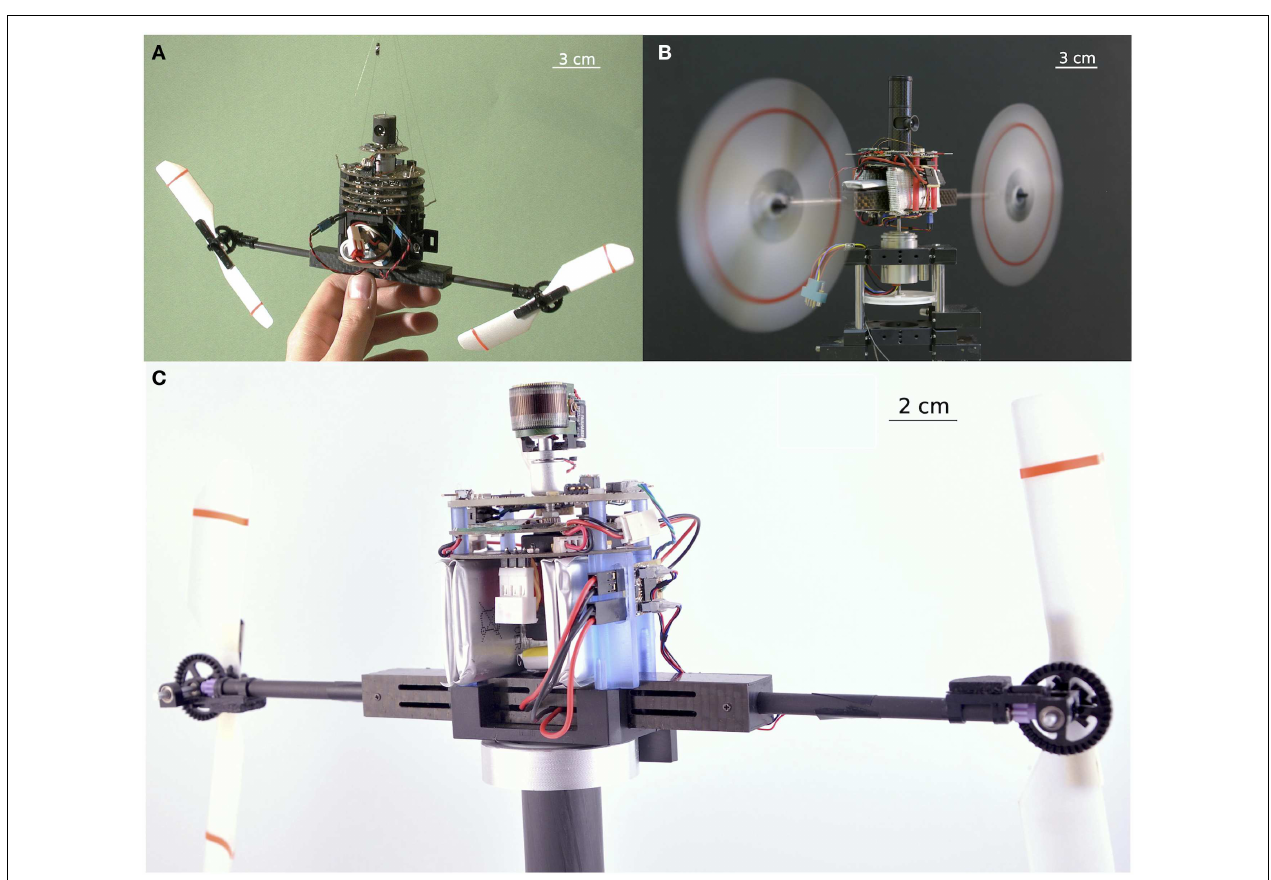
(Viollet and Franceschini, 1999a,b, 2001). (B) TheVODKA robot equipped with its scanning eye, on which periodic micro-scanning movements were imposed by means of a piezo bender translating the two photodiodes placed behind a fixed lens (Kerhuel et al., 2007, 2010, 2012).TheVODKA robot was able to locate a contrasting feature with a 900 times greater accuracy than its static optical resolution (without any micro-movements of the eye). (C) The HyperRob robot equipped with the active version of the artificial curved compound eye called CurvACE (Floreano et al.,